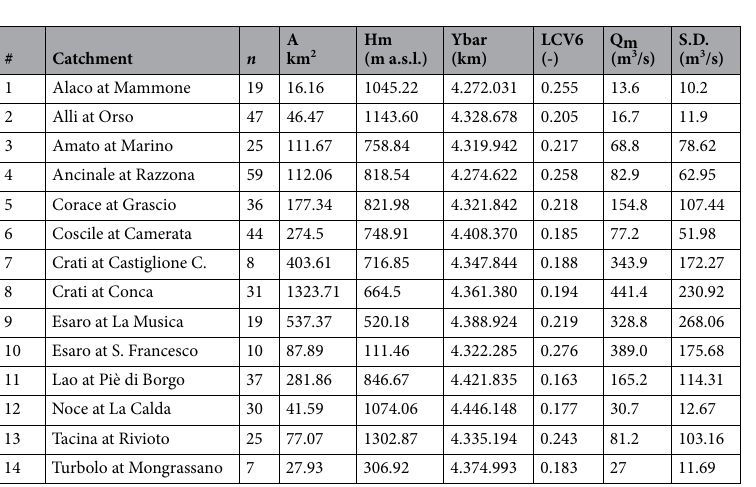
Figure 1. Watersheds location, obtained using ArcGIS Desktop: Release 10.3.1. Redlands, CA: Environmental Systems Research Institute (left panel) and extent of the observation period for each recording gauge (right panel).